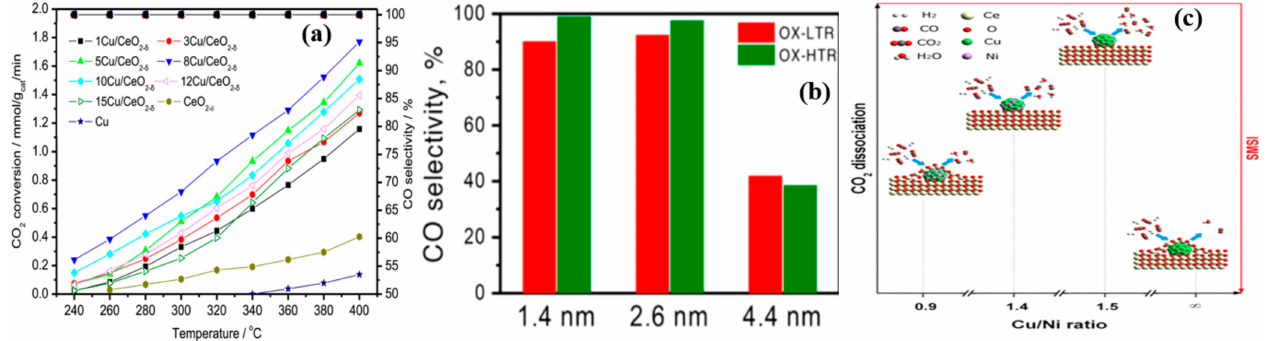
Figure 12. Effect of Effect of metal–support interactions on metal-CeO 2 in RWGS reaction: ( a ) Cu- CeO 2 , reprinted with permission from [149]. Copyright Elsevier, 2020, ( b ) Ru-CeO 2 , reprinted with permission from [55]. Copyright ACS, 2018, ( c ) Cu x Ni 1–x -CeO 2 , reprinted with permission from